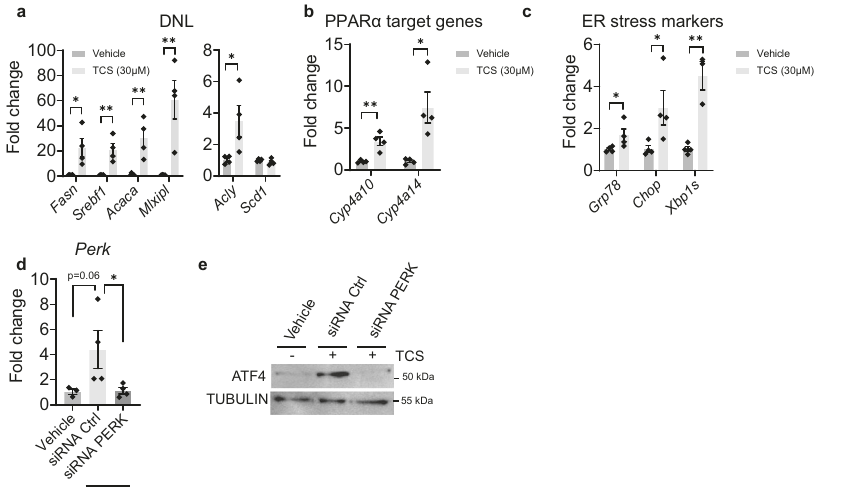
Fig.2|TCSstimulatesDNL,ERstressandPPAR α inmouseprimaryhepatocytes and ATF4 induction is PERK dependent. Mouse primary hepatocytes were iso- lated from one month old mice and were placed in medium with DMSO or in the presence of 30 µ M of TCS. After 72h of exposure the hepatocytes were collected for Q-RT-PCR analysis. a TCS stimulates genes associated with DNL, n =4 samples pergroup. b DownstreamPPAR α targetgenes, n =4samplespergroup. c Induction of genes associated with ER stress, n =4 samples per group. d Hepatocytes were